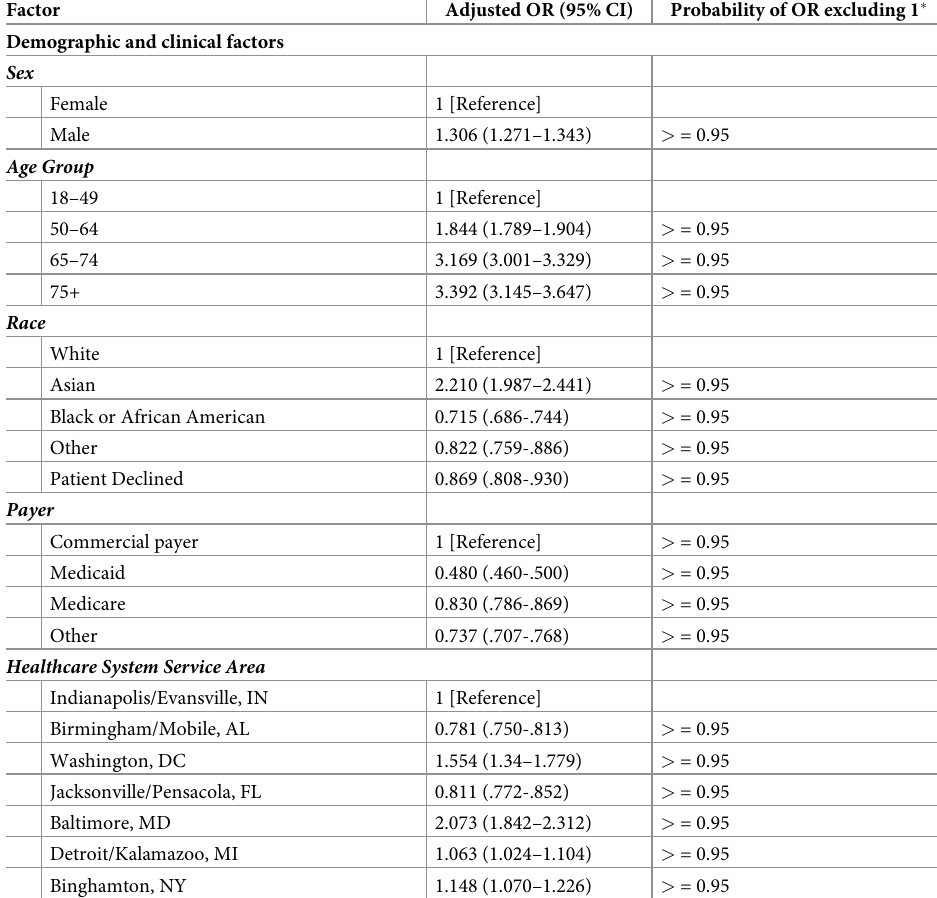
Table 2. Results of a Bayesian regression analysis, adjusted for demographic/clinical, occupational, and social risk factors, on response of "very/somewhat likely to